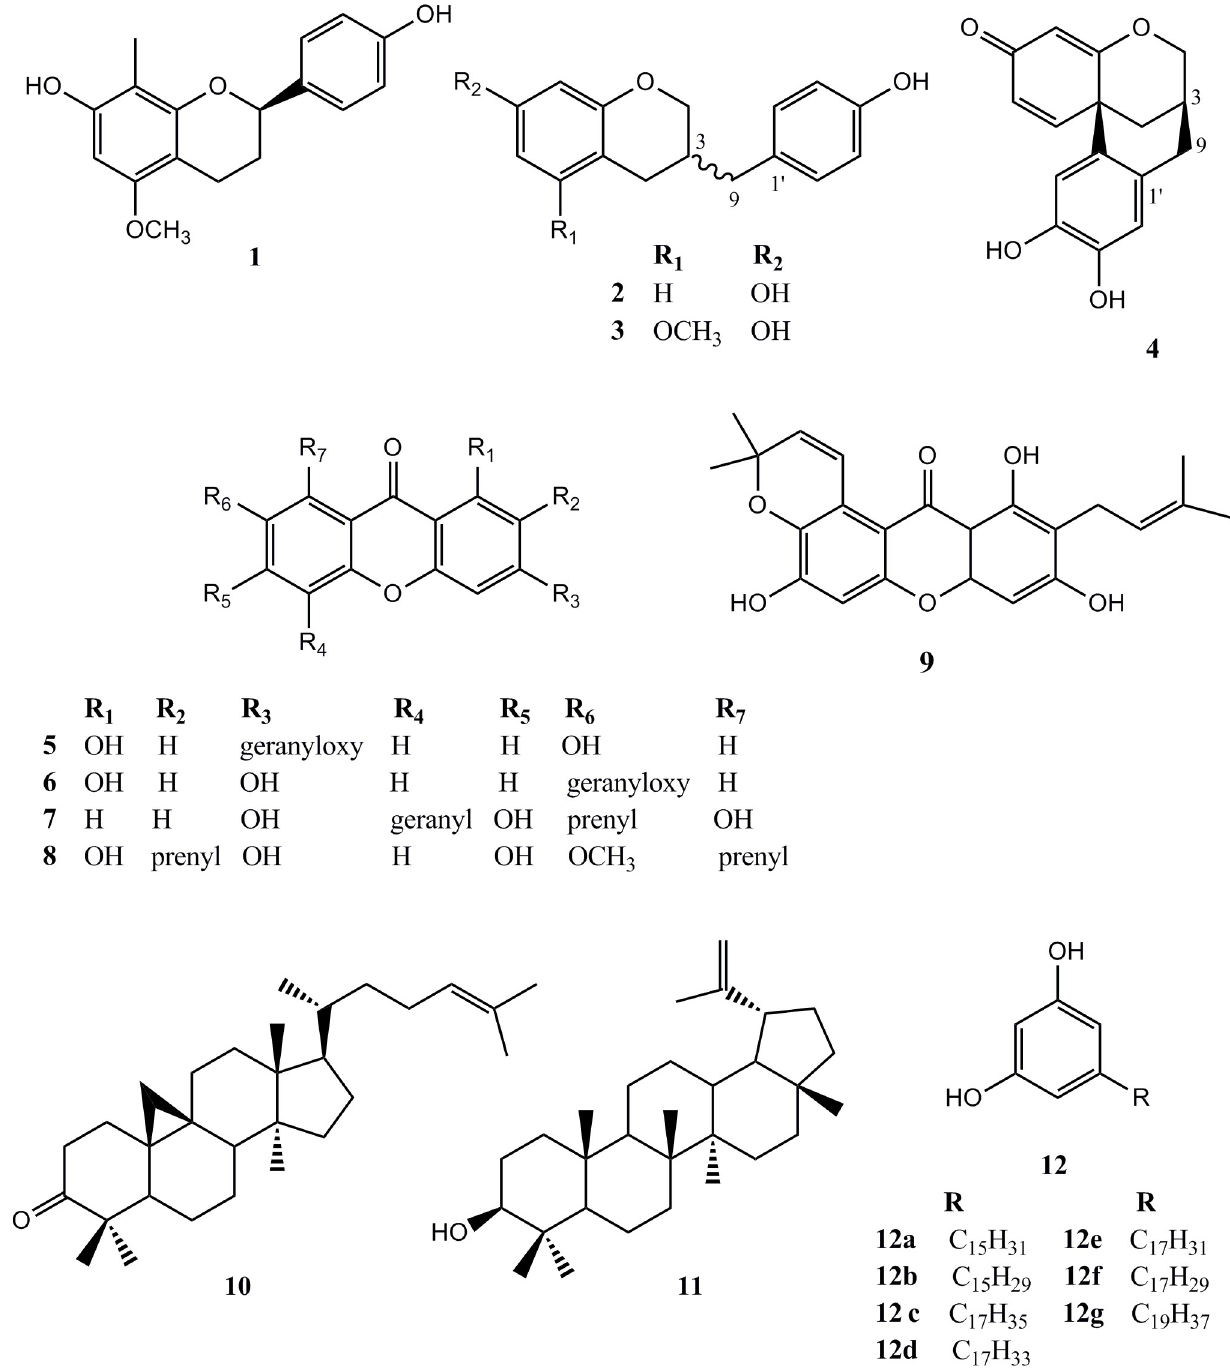
Fig 2. Chemical structures of isolated